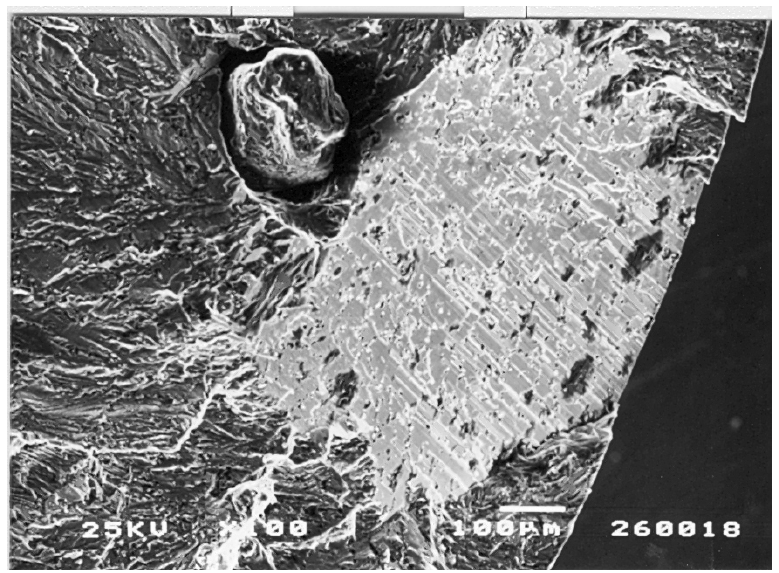
Figure 12. Fatigue fracture of Al–7Si–0.4Mg alloy showing facet generated from the oxide bifilm partly wrapped around the entrained sand grain [35].